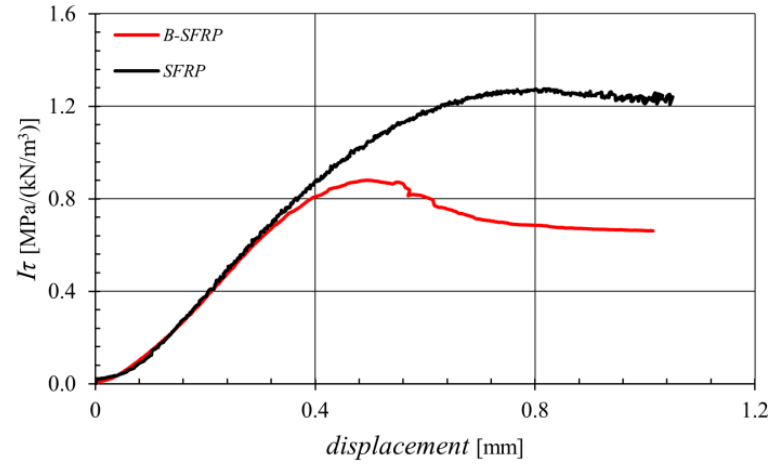
Figure 16. Specific shear curves obtained by the ILSS test for both the biocomposites examined. In accordance with the considerable mismatch of the elastic properties of the two different fibers, sisal and basalt, as well as with what has already been observed in terms of the damage mechanisms of biocomposites under tensile stress, from Figure 16 it can be seen that the hybrid biocomposite had a lower delamination strength. In other words, in the absence of aging (virgin material), hybridization resulted in a 30% reduction with respect to the performance of the SFRP